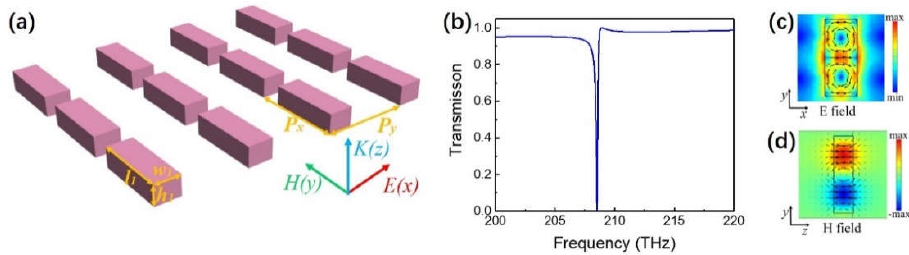
Figure 1. ( a ) A high-Q 2D RMS consisting of a silicon rod array surrounded by air. The length, width and height of the rod are represented by l 1 , w 1 , and h 1 , and the periods of the unit cell in the x and y directions are P x = P y = 900 nm. ( b ) Transmission of 2D RMS when l 1 = 800 nm, w 1 = 335 nm and h 1 = 200 nm. ( c ) Near-field electric field diagram and displacement current (arrow) distribution at the resonance. ( d ) Near-field magnetic field diagram at the resonance.